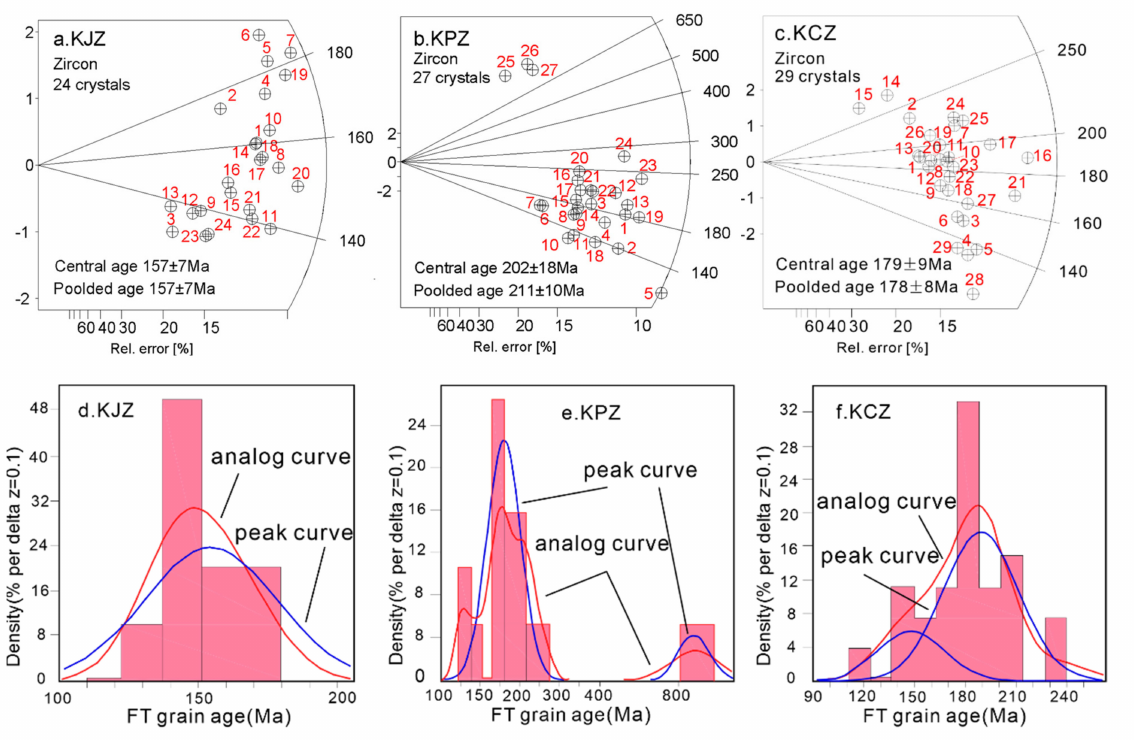
Figure 5. ( a – c ) The grained zircon age radar diagram; ( d – f ) the fission track age frequency distri- bution, ( a , d ) sandstone from the Datong Formation; ( b , e ) sandstone from the Shanxi Formation; ( c , f ) sandstone from the Taiyuan